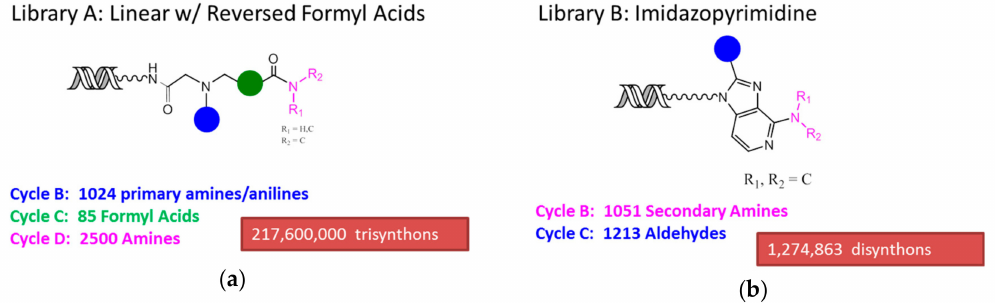
Figure 1. Schemes of the DNA-encoded libraries A and B: ( a ) Library A was a three-cycle linear library with formyl acid cores comprising 217.6 million individual unique compounds; ( b ) Library B was a two-cycle imidazopyrimidine core library comprising 1.275 million individual unique compounds.